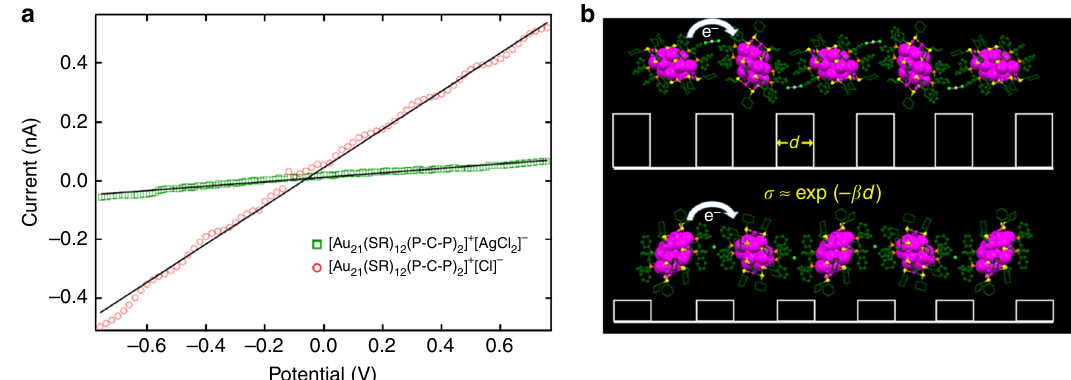
Fig. 6 Electron transport properties of the Au 21 NP assemblies. a Room temperature conductivity of the single crystals of [Au 21 (SR) 12 (PCP) 2 ] + [AgCl 2 ] − (green) and [Au 21 (SR) 12 (PCP) 2 ] + [Cl] − (red), respectively. b Schematic diagram of the electron hopping in Au 21 NP assemblies. Different con fi gurations of the interacting π – π pairs result in different height of tunneling barriers (white solid squares), thus changing the electron conductivity (e − represents the electron; σ is the conductivity; d is the interparticle distance, and β is the tunneling decay constant)